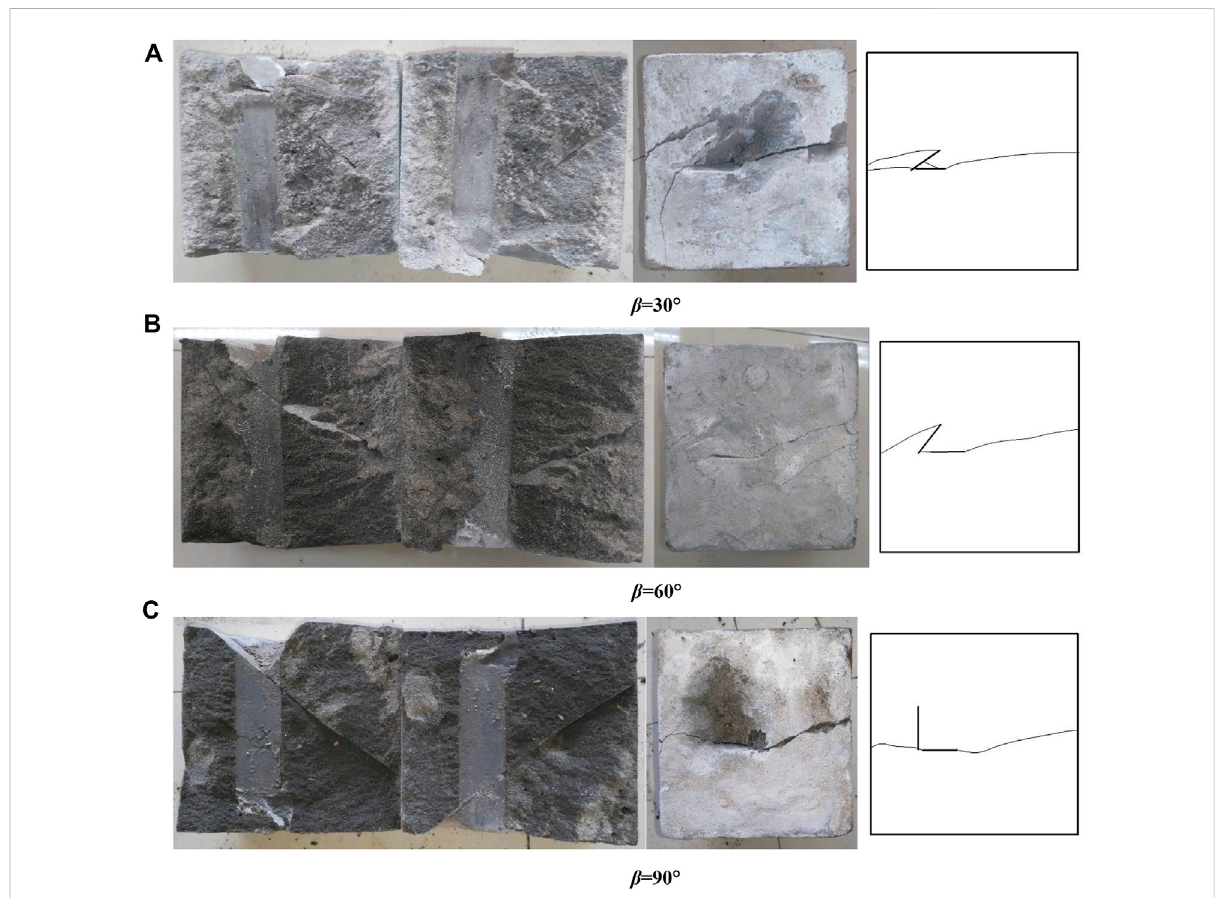
FIGURE 11 Shear failure surface and form of specimens under normal stress of 5 MPa ( α = 45 ° ). (A) β = 30 ° , (B) β = 60 ° , (C) β = 90 °